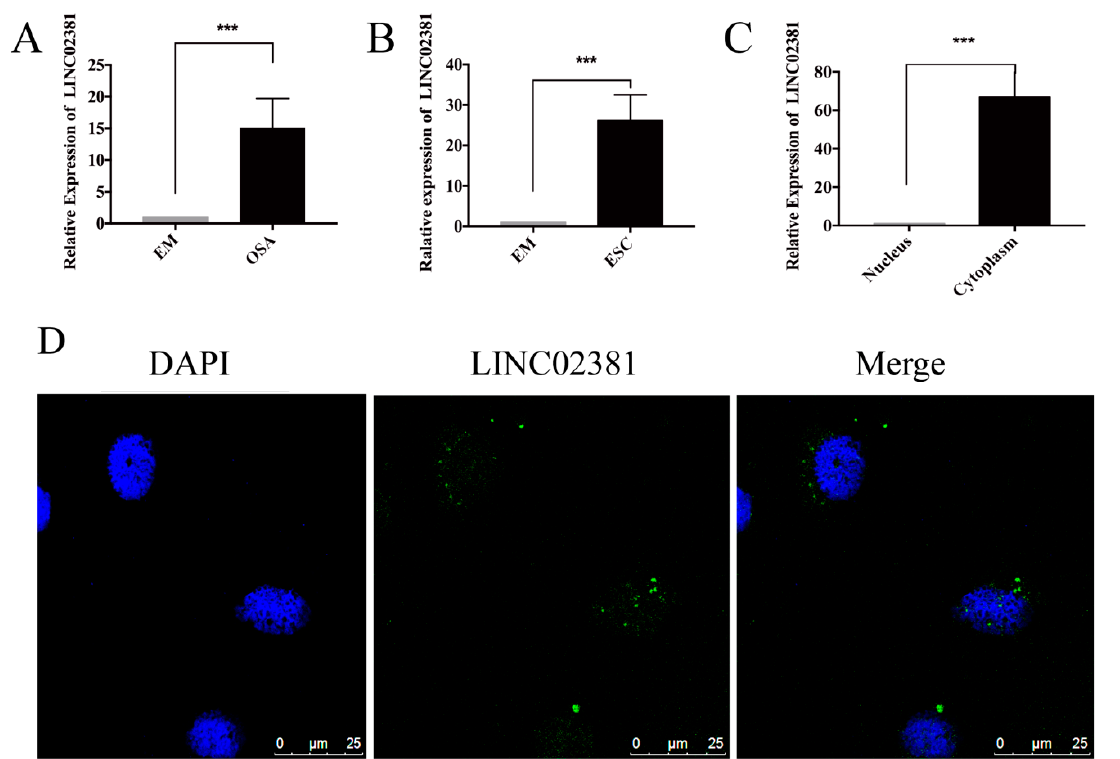
Figure 2. Expression and distribution of LINC02381. ( A ) Paired OSA and EM samples were harvested for real-time quantitative polymerase chain reaction (qRT-PCR) to quantify the RNA expression of LINC02381 ( n = 21, P < 0.001). ( B ) Paired ectopic endometrial stromal cells (ESCs) and eutopic endometrial stromal cells (EMs) were collected for qRT-PCR to quantify the RNA expression of LINC02381 ( n = 17, P < 0.001). ( C ) ESCs were harvested for cytoplasmic and nuclear fractionation experiments and qRT-PCR ( n = 3, P = 0.000). ( D ) ESCs were harvested for RNA fluorescent in situ hybridization (FISH) to determine the distribution of LINC02381. *** P < 0.001 vs. individual